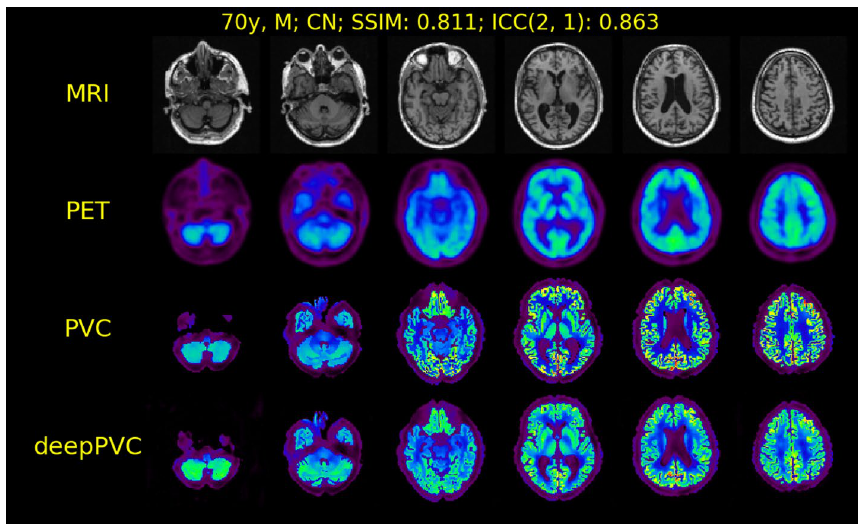
Both results are for the prediction with deepPVC MRI